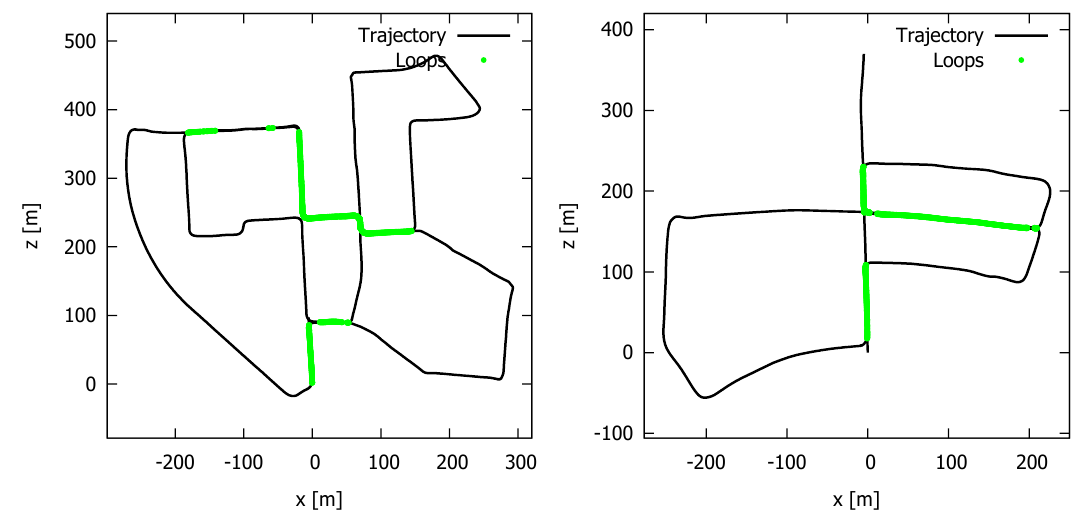
Figure 5. The ground truth loops in the “00” ( left ) and “05” ( right ) sequences of the Kitti benchmark [30]. We consider a loop to be present when the distance between two poses is less than 1